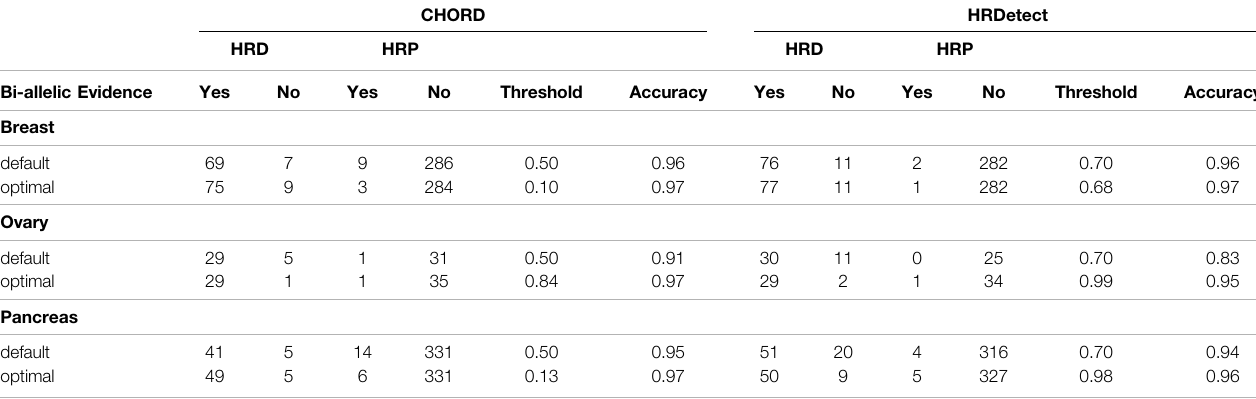
TABLE 2 | Summary table of confusion matrix results with accuracy for default and optimal (cancer-type-speci fi c) threshold values of CHORD and HRDetect classi fi ers for classifying samples as homologous recombination de fi cient (HRD) or homologous recombination pro fi cient (HRP). CHORD HRDetect HRD HRP HRD